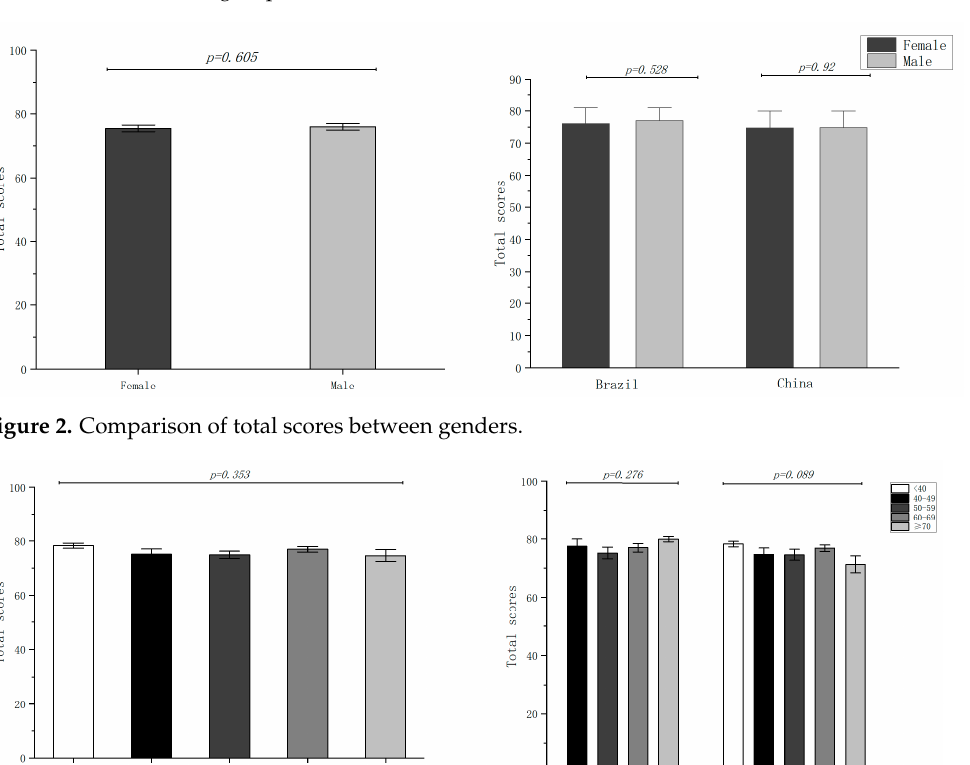
Figure 3. Comparison of total scores between age groups. Figure 2. Comparison of total scores between genders.